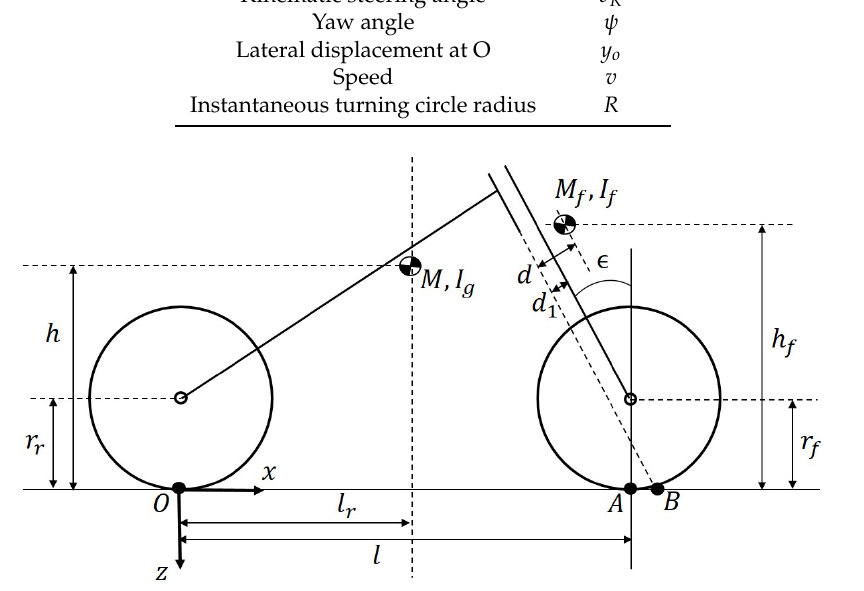
Figure 2. A typical layout of a motorcycle.